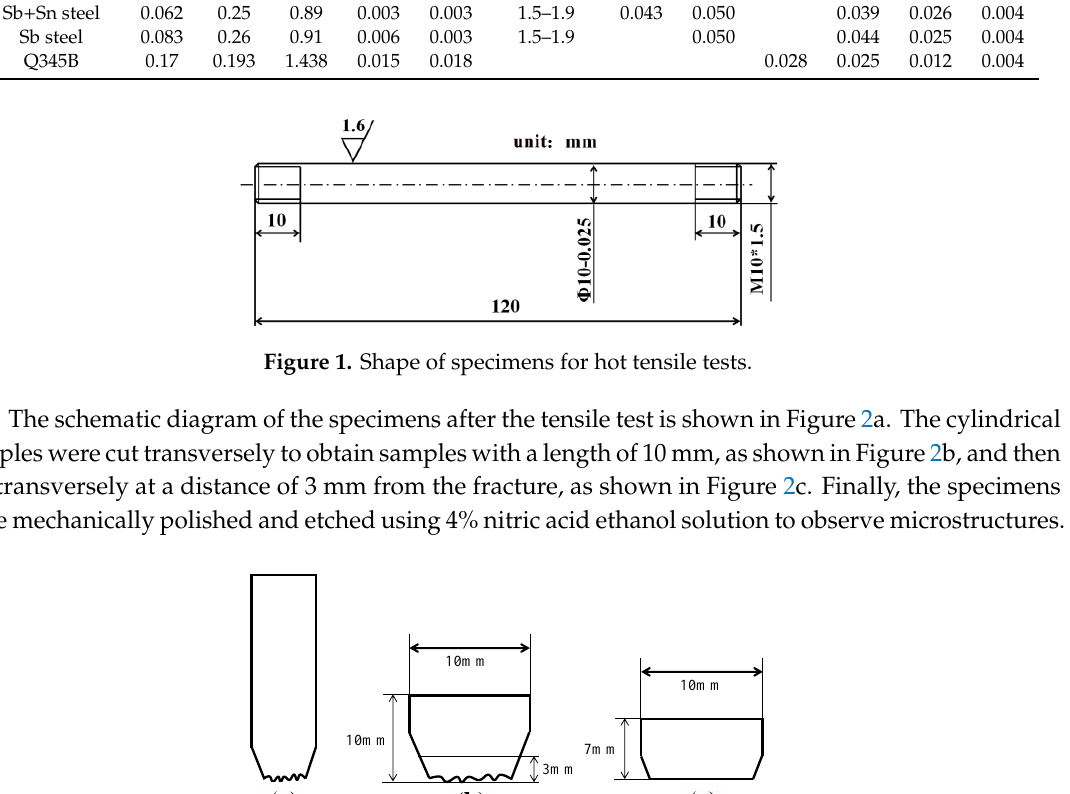
Figure 2. Schematic diagrams of specimen processing showing ( a ) The specimen after fracture; ( b ) the specimen near the fracture surface; ( c ) the final specimen used for microstructure observation.